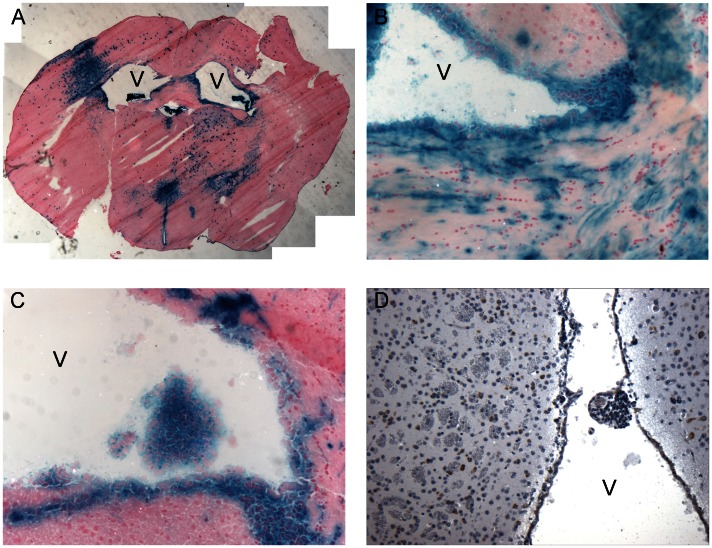
Cre-mediated recombination in Tsc1c/c mice after neonatal delivery of AAV1-CBA-Cre vector (2×1010 g.c. per 2 µl into each ventricle).(A) Three months after ICV vector injection into Tsc1c/cROSA homozygous pups, frozen sections were stained with X-gal and counterstained with Nuclear Fast Red. Intense lacZ staining was visualized in clusters throughout the brain(coronal section, anterior to hippocampus region); note enlarged ventricles (V). Magnification = 2X. (B) The ventricular lining showed patches of lacZ staining and thickening. (C) Nodule-like structure, composed of cells in which Cre recombination has been induced as visualized by X-gal staining, were observed in the ventricles. (D) H&E staining showing nodule along ventricular lining. The regions in B, C & D are taken at a level close to the anterior amygdala. Magnification B, C & D = 10X.